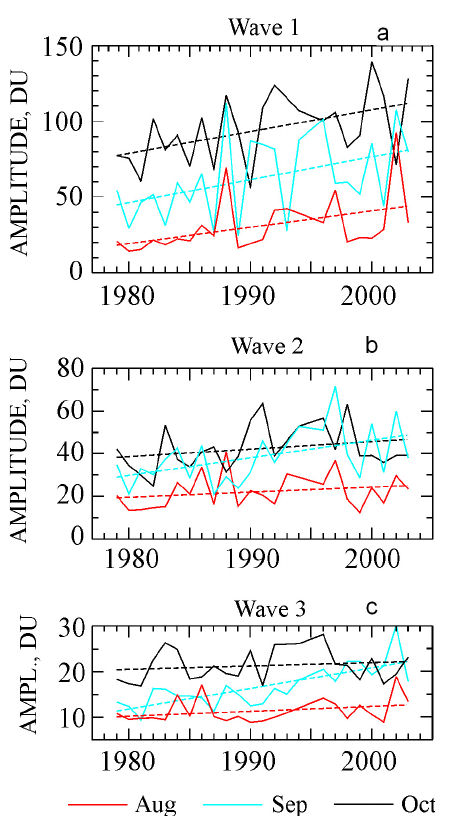
Fig. 5. Comparison of long-term trends in amplitude of the wave numbers 1–3 during August (red line), September (blue line) and October (black line).